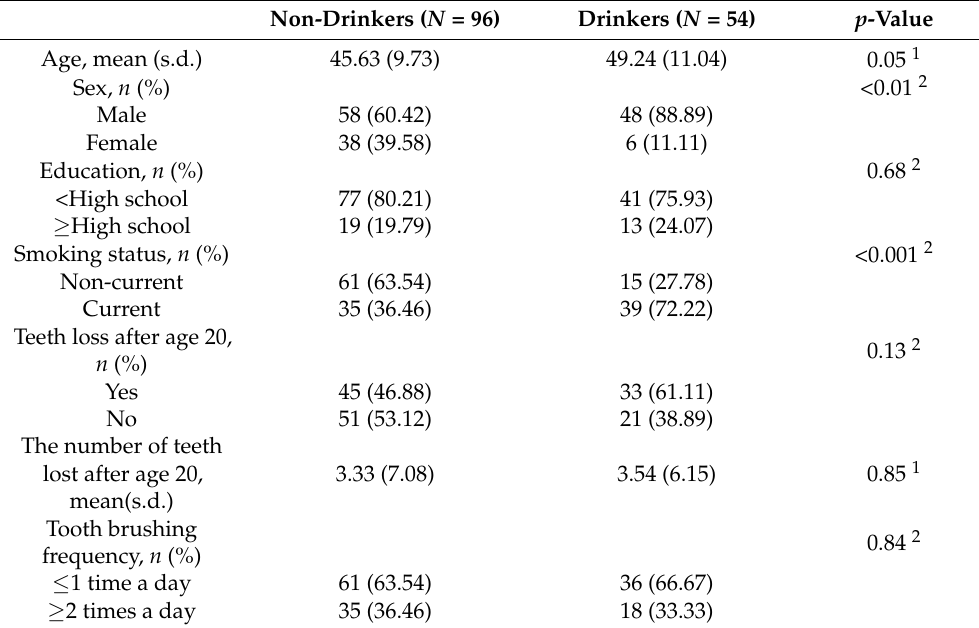
Table 1. Demographic characteristics among non-drinkers and drinkers. Non-Drinkers ( N = 96) Drinkers ( N = 54) p -Value Age, mean